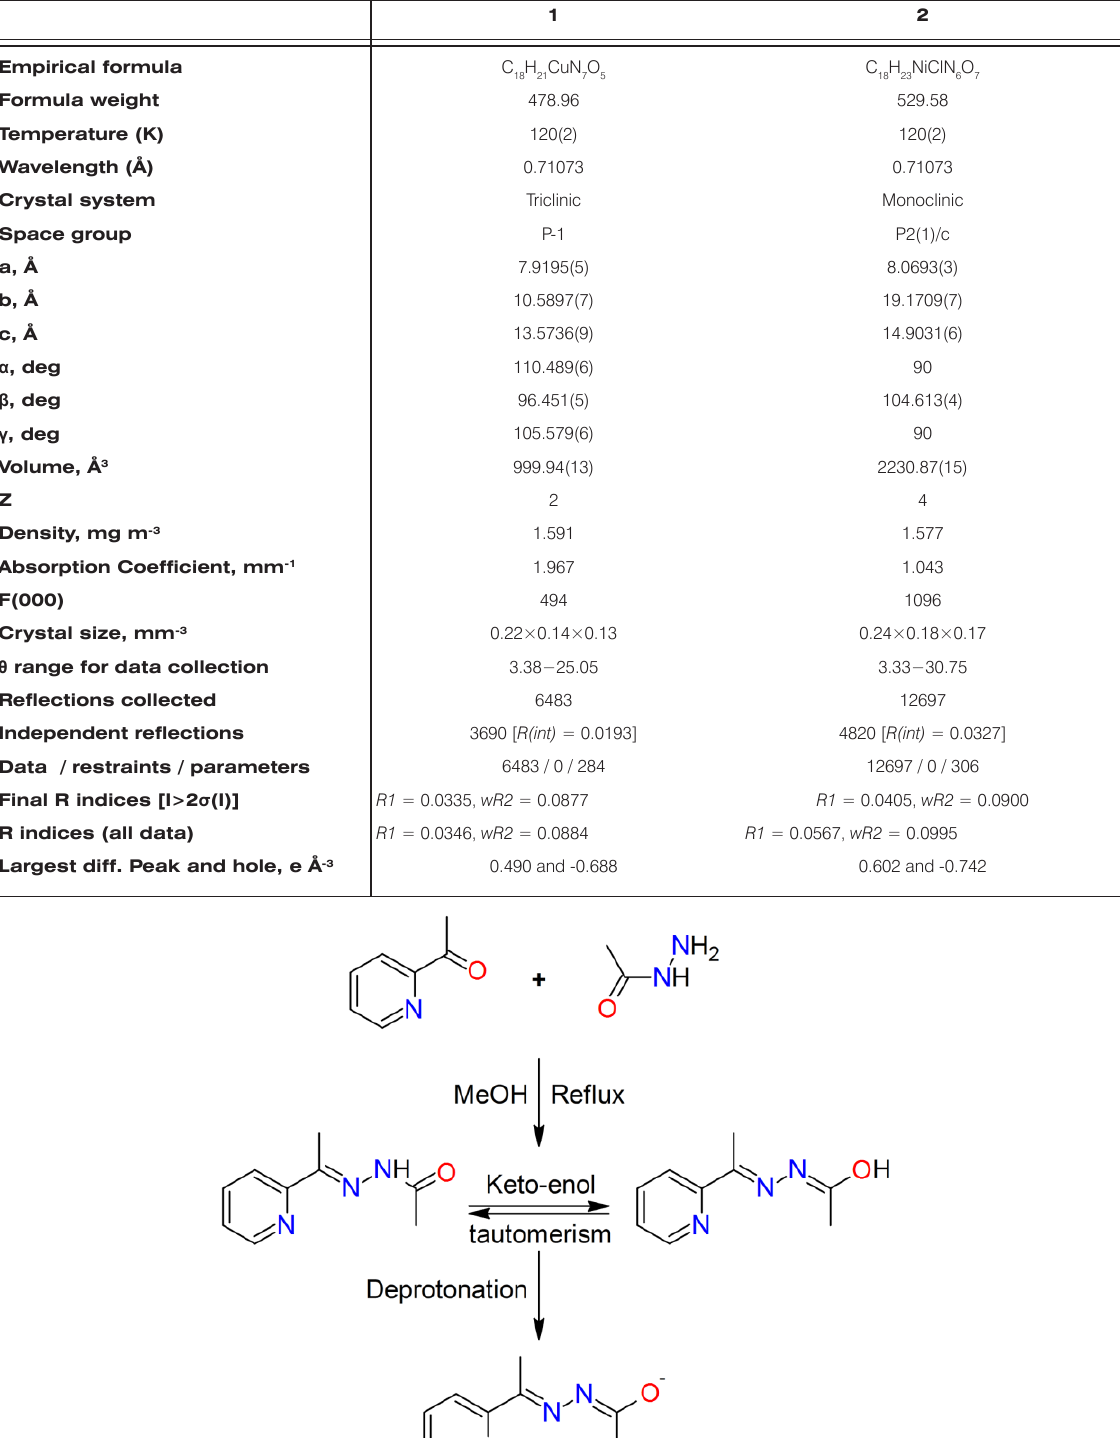
Table 1. Crystallographic data of 1 and 2